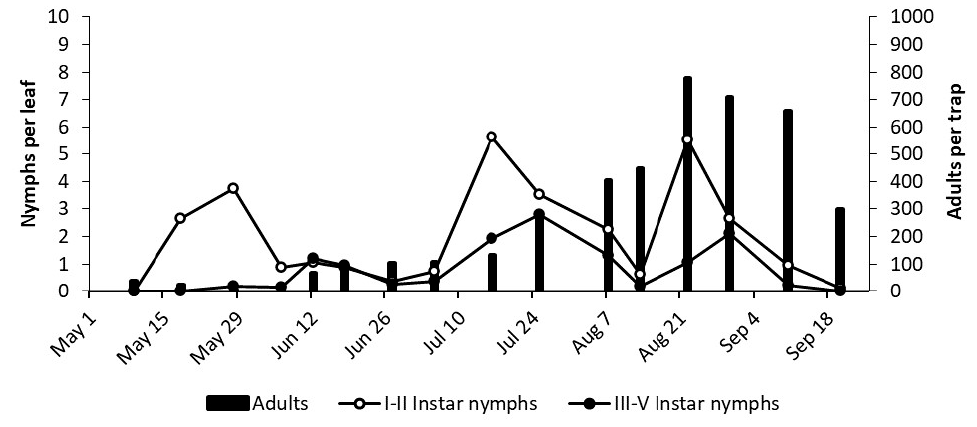
Figure 7. The phenology of E. vulnerata in MO vineyard in the growing season of 2018.